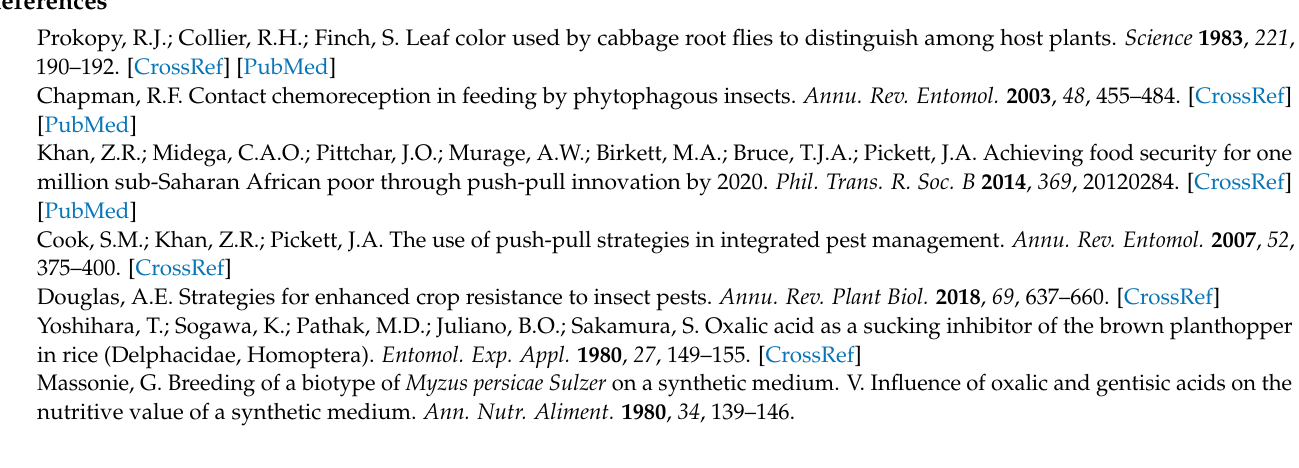
Table S2: Identification of differential peaks by GC-MS, Figure S1: The nucleotide sequences of human codon-optimized NlGr23a genes, Figure S2: The gene structure of NlGr23a, Figure S3: Isola- tion and identification of rice crude extracts, Figure S4: Responses of the Nl Gr23a-HEK293T cells to different phytochemicals, Figure S5: NlGr23a expression levels in BPHs after RNAi, Figure S6: OA content in different rice plants, Figure S7: OA induced feeding avoidance, Figure S8: The duration of each waveform as a proportion of observation time produced by ds NlGr23a - and ds GFP - treated BPHs on LDS containing artificial diets with 2 mM or 5 mM